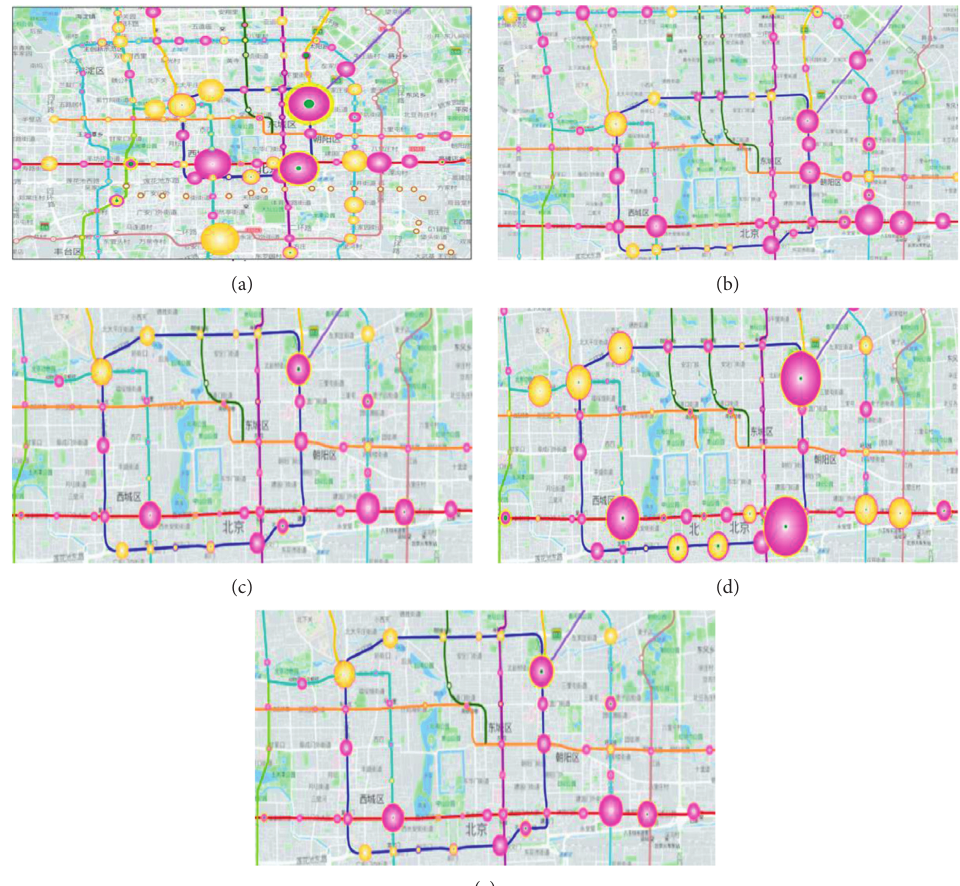
Figure 9: Spatial distribution of passengers by their dependency variety: (a) c 0, (b) c 1, (c) c 2, (d) c 3, and (e) c 4.